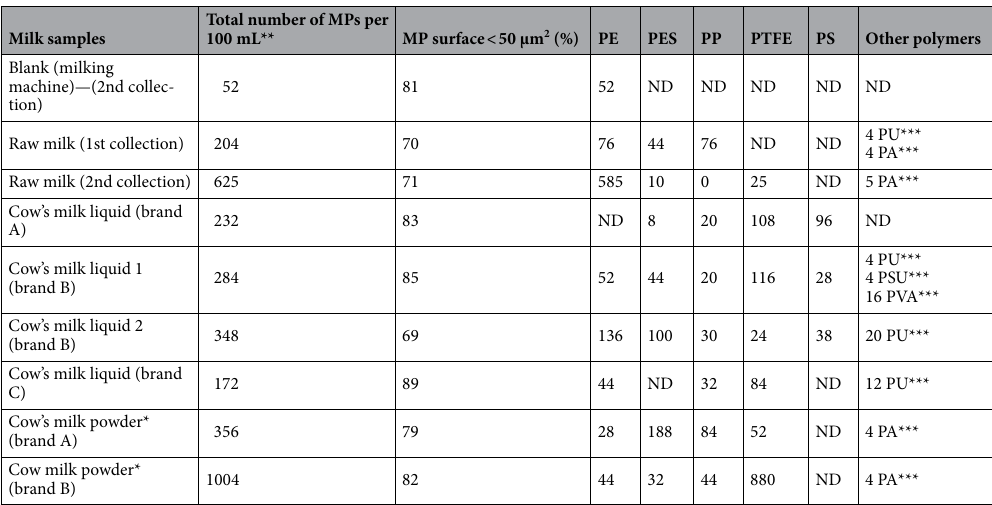
Table 2. Number and type of MPs detected in cow’s milk samples. ND not detected. *Reconstituted cow’s milk samples (13 g powder in 100 mL water which corresponds to the serving size of liquid and reconstituted cow’s milk samples with a standard nutritional energy of ca 67 kcal for milk products). **Values subtracted from the blank. ***PA: polyamide; PU: polyurethane; PSU: polysulfone; PVA: polyvinyl